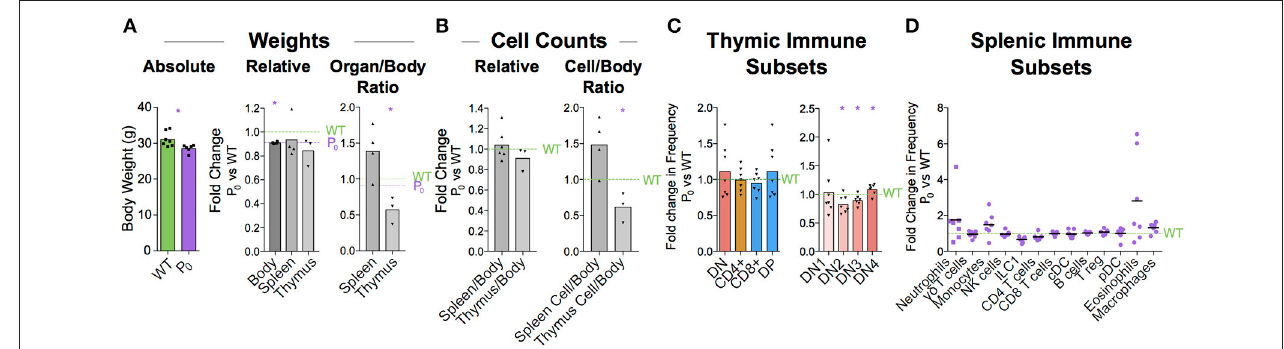
FIGURE 8 | Immune cell deficiency persists into adulthood. (A) Absolute weights of 8 week male P 0 and WT were compared ( n = 7, 6). Body ( n = 7, 4), spleen ( n = 7, 4), and thymus ( n = 5, 3) weights were compared with littermate controls. Spleen/body and thymus/body weight ratios were also compared relative to littermate controls to account for lower overall body weight in the P 0 mice. (B) Total cells within the spleen ( n = 4, 4) and thymus ( n = 5, 3) were compared directly with littermate controls as well as relative to overall mouse weight. (C) Surface markers were used to classify T cells within the thymus and the proportions were compared to littermate controls ( n = 8, 7). (D) Splenic immune subset proportions were determined from flow cytometry and compared with littermate controls ( n = 5, 7). Datasets were tested for normality using the Shapiro-Wilk normality test. Normal data were compared using unpaired two-tailed t -tests while nonparametric data were compared using Mann-Whitney Rank comparison tests. For all tests, * P <